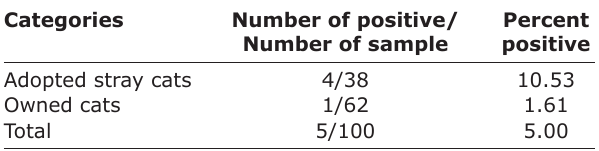
Table-1: Detection of antibodies to Toxoplasma gondii in cats, in Khao Suan Kwang and Mueang Khon Kaen District, Thailand.